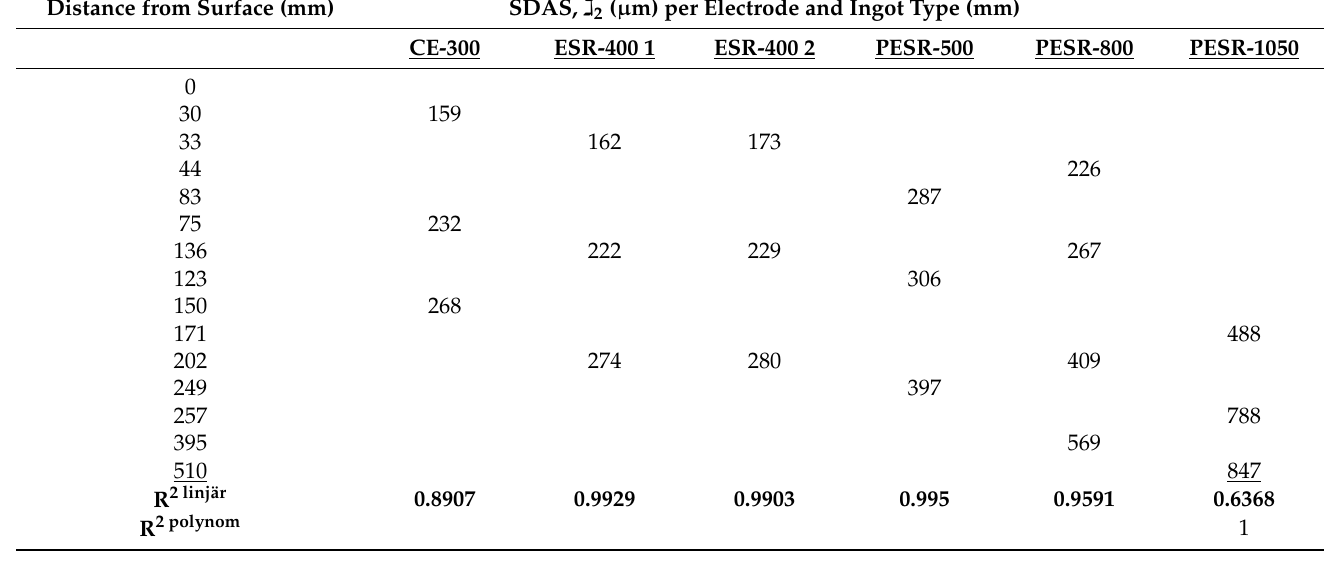
Table 2. Secondary dendrite arm spacing (SDAS, ג 2 ) per distance from the surface for the electro de 300 × 300 mm 2 (CE-300), the electro-slag remelted ingots 400 × 400 mm 2 (ESR-400 1,2), and the pressure electro-slag remelted ingots with 500–1050 mm diameter (PESR-500, PESR-800, and PESR-1050). Distance from Surface (mm)